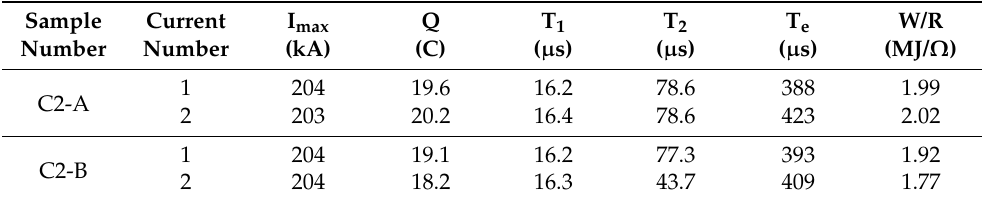
Table 4. Current parameters of the tests of the 2 samples of configuration 2 (combination of segmented and solid diverter